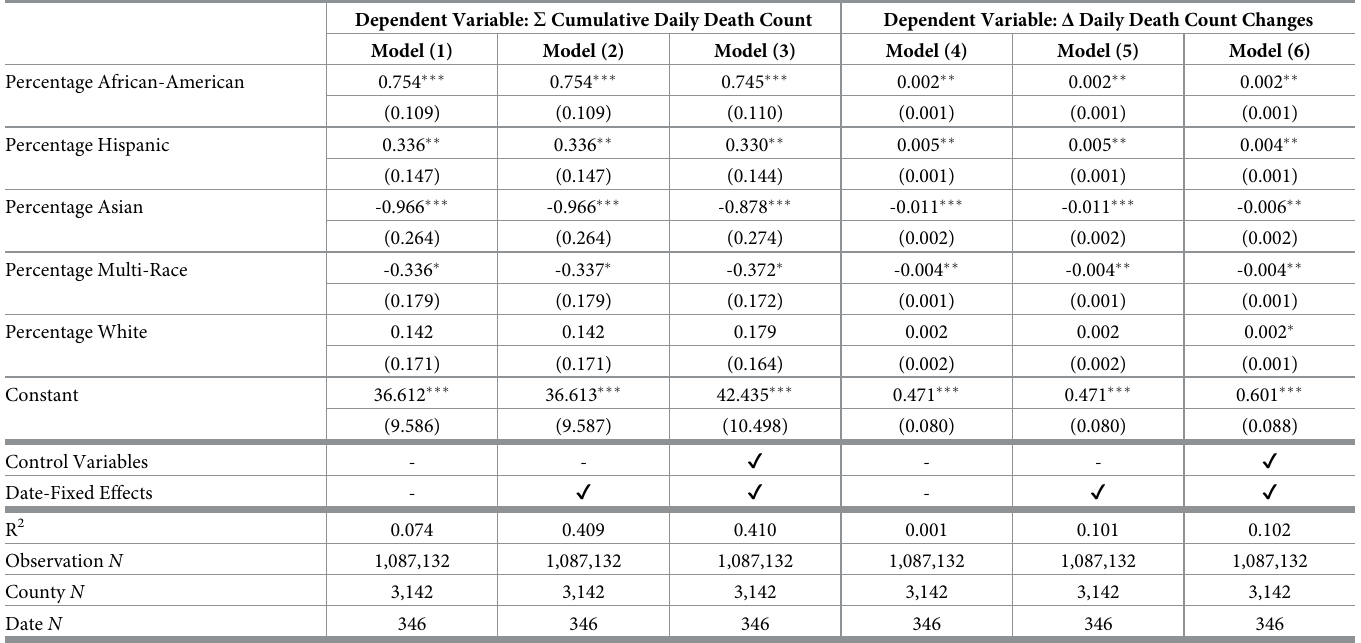
Table 1. County-level high dimensional regression models assessing racial disparities in COVID-19 death, January 21 st –December 31 st